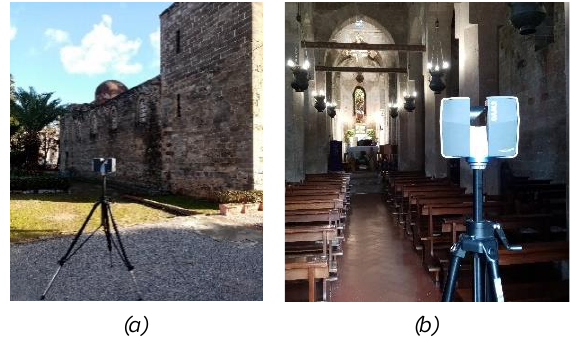
Figure 1 . The exterior of the church.